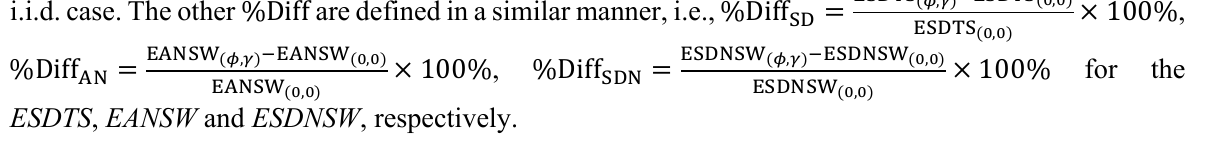
The values of 𝑘 for the zero- and steady-state VSSI-Runs and VSSI-Synth schemes when 𝑘 (cid:2870) 4.0}, H ∈ {1,2,…,20}, ATS 0 =370.4 and 𝑘